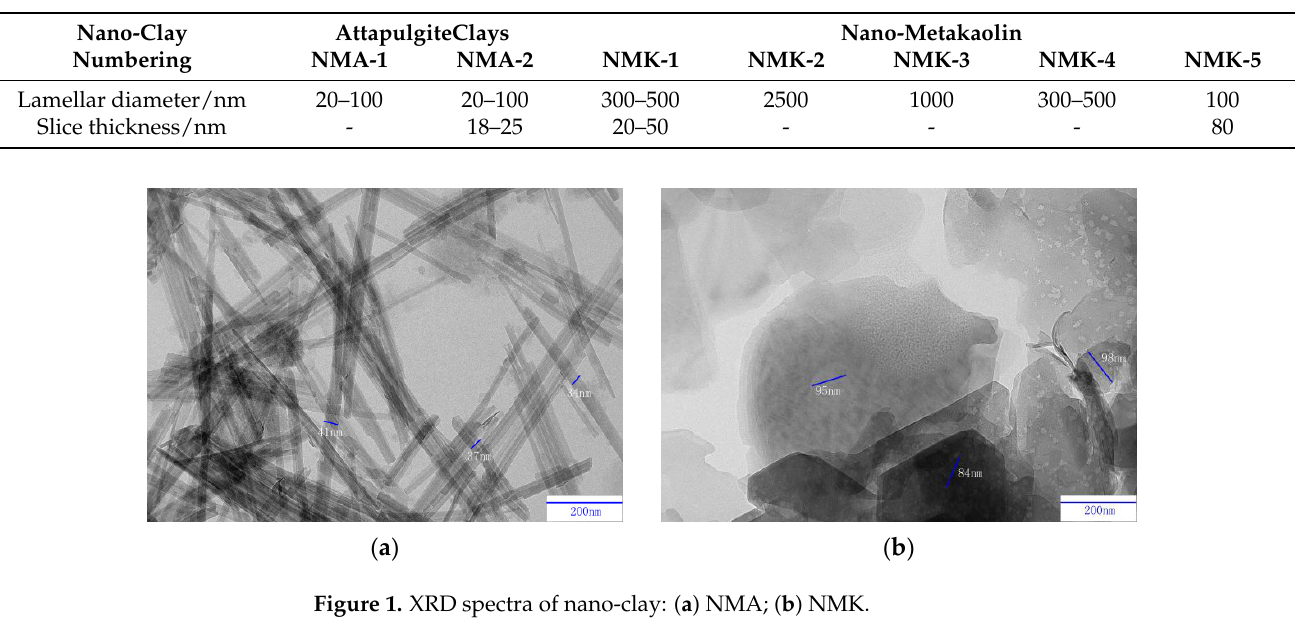
Table 2. Physical performance index.